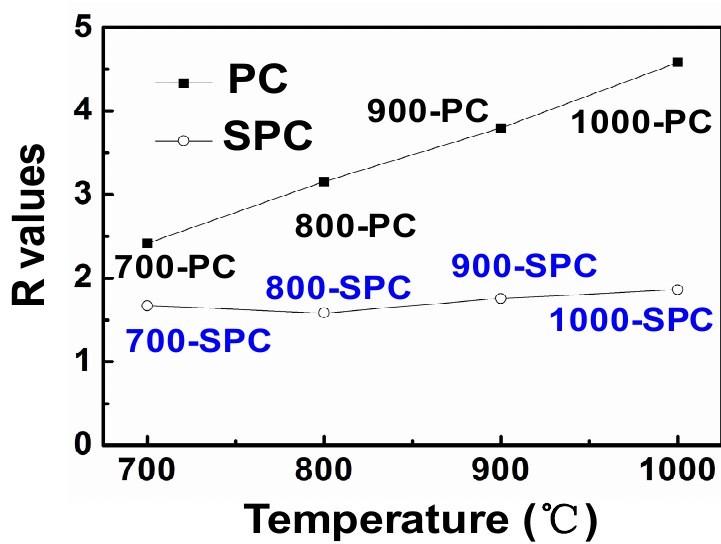
In addition, R values (obtained by calculation according to the XRD measurement results) are generally used to describe the degree of disorder [22,23]. Namely, low R values reflect that carbon materials possess a disordered structure. Like the report of Liu et al., and based on the XRD results (Figure 3e–i), the R values were calculated in detail [22]. As shown in Figure 4, the R values of PC and SPC materials show similar tendencies whereby the R values decrease with decreasing carbonization temperature. In addition, compared with the PC materials, it is seen that the SPC materials exhibit more disordered structures (Table S4). In particular, the 800-SPC material showed the smallest R value of all materials, which is ascribed to the fact that 800-SPC possesses more S contents than other SPC materials (Figure 4, Table S4).